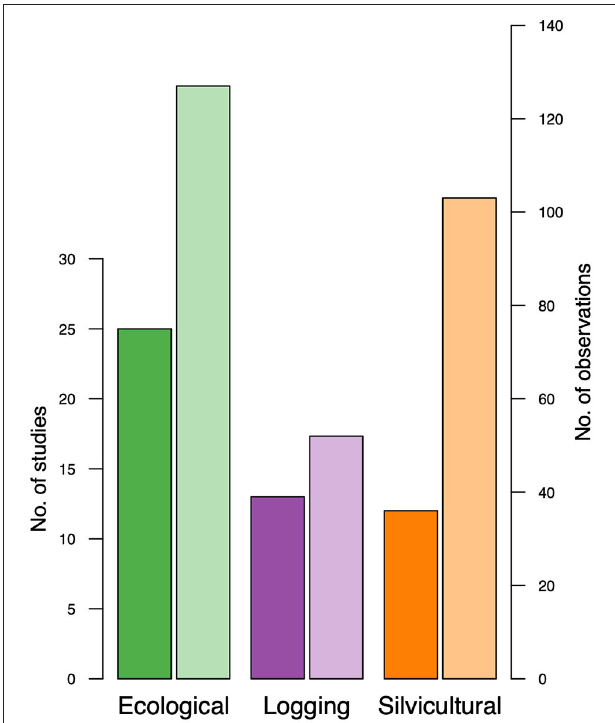
FIGURE 1 | Number of liana removal studies and observations within studies used to conduct three-level meta-analyzes for ecological, logging, and silvicultural experiments. Number of studies in darker colors, number of observations in lighter